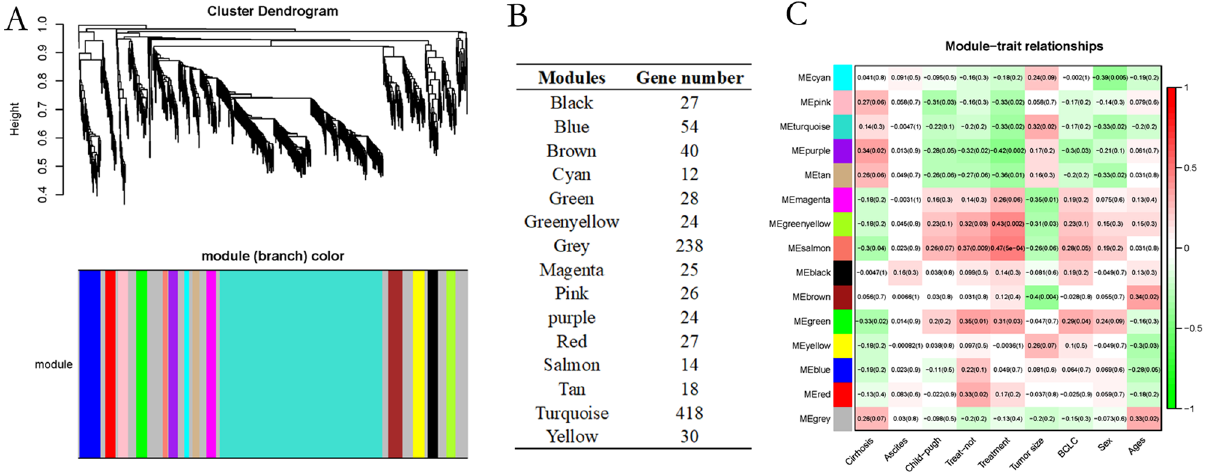
Figure 6. Co-expression modules analysis with WGCNA. It was created using R version 4.0.2, https:// www.r- proje ct. org/. ( A ) HCC gene co-expression DEG modules. There are various colors under the dendrogram